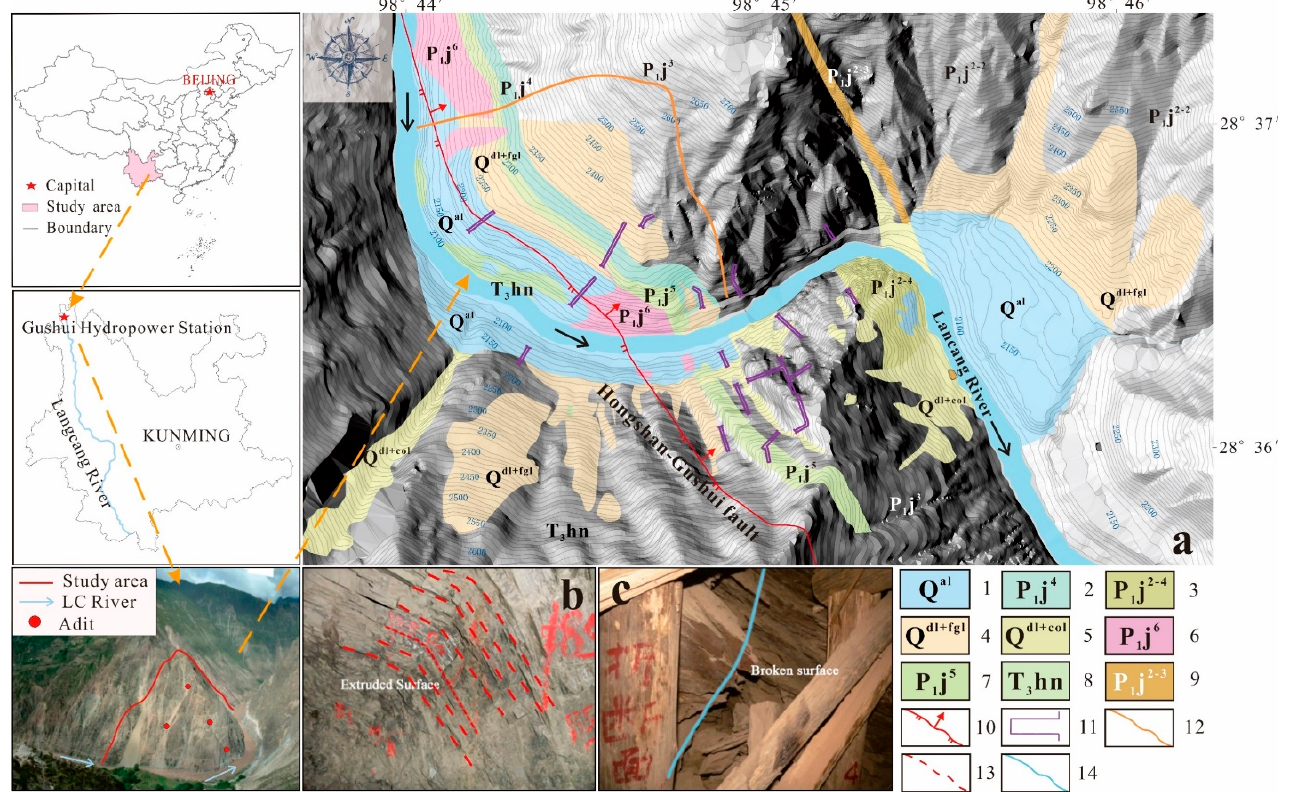
Figure 2. The toppling deformation slope in front of the dam of the Gushui Hydropower Station. ( a ) Engineering geological planar graph of the study area, 1 Alluvium deposit, 2 4th section of the Permian Jidonglong Formation, 3 2nd–4th section of the Permian Jidonglong formation, 4 diluvial layer and ice water accumulation layer, 5 diluvial layer and colluvium, 6 6th section of the Permian Jidonglong formation, 7 5th section of the Permian Jidonglong formation, 8 upper Triassic Hongpo formation, 9 2nd–3th section of the Permian Jidonglong formation, 10 Hongshan-Gushui thrust fault, 11 Adit, 12 study area, ( b ) zone with extremely strong toppling deformation, 13 Extruded surface, ( c ) zone with extremely strong toppling deformation, 14 broken surface.